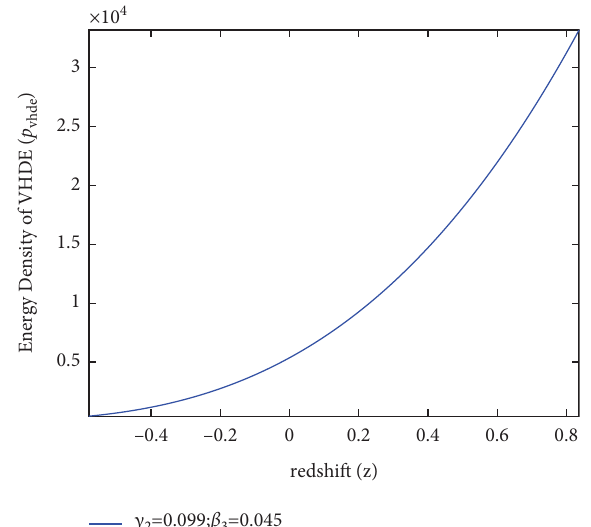
Figure 5: Energy density of VHDE ( ρ